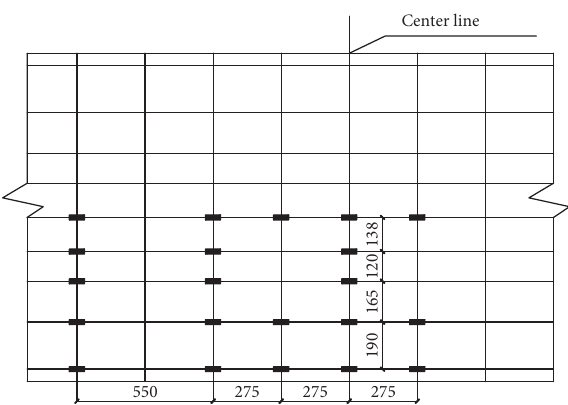
Figure 12: Layout of PLG-1 reinforcement measuring point (unit: mm).